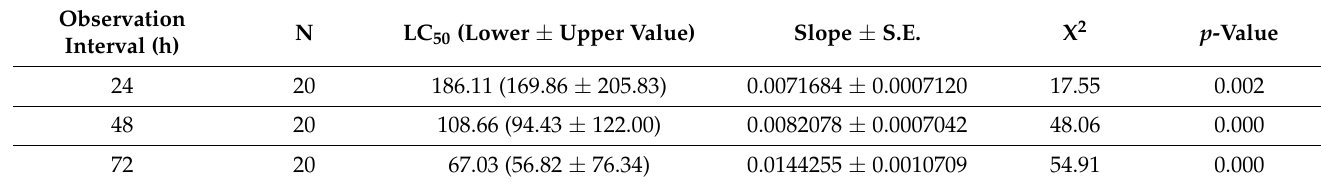
Table 3. Toxicity of BEHP against C. quinquefasciatus